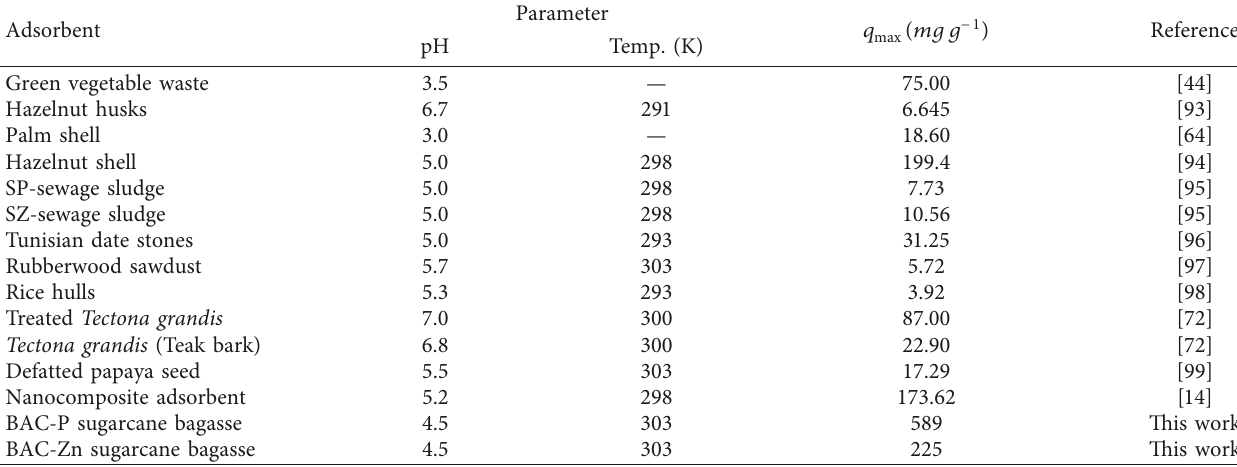
Table 9: Comparison of the maximum monolayer adsorption capacity for Cu(II) ions onto various adsorbents.